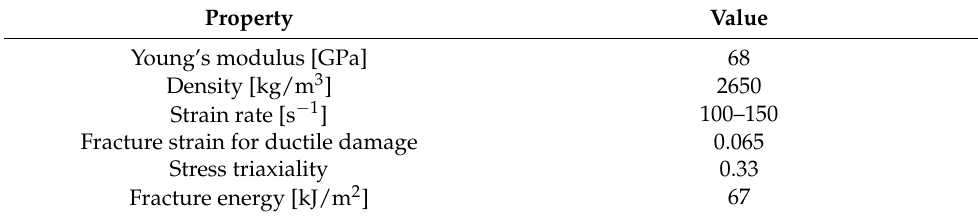
Table 2. Elastic and fracture properties of the AlSi10Mg alloy.